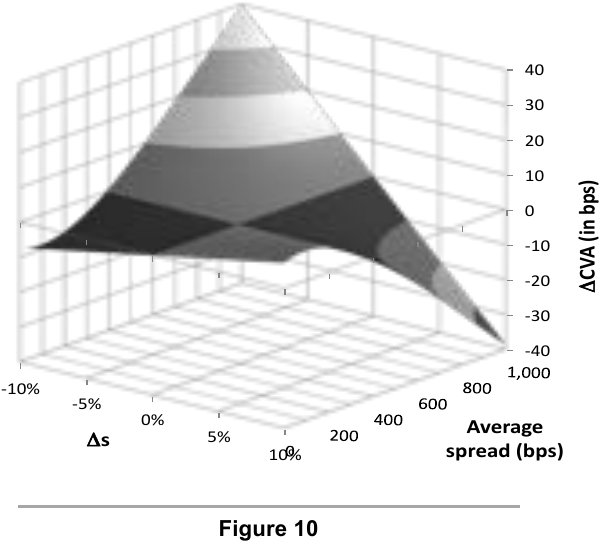
Effect on Δ CVA of Δ s for various average spreads. For a recovery rate of 55 per cent at average spreads of ≈ 400 bps, Δ CVA/ Δ s% ≈ %